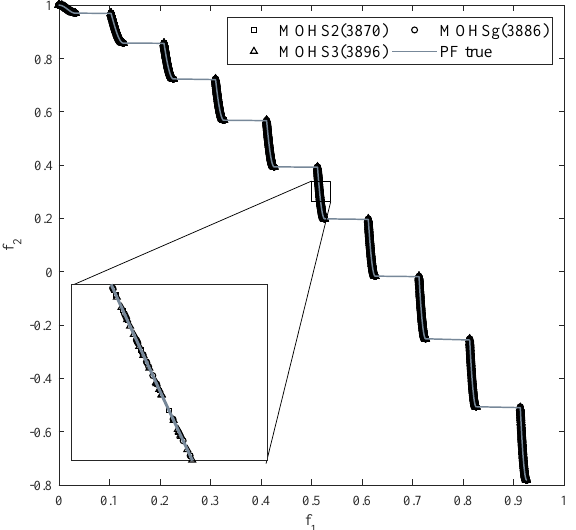
Figure 8. Pareto fronts for problem